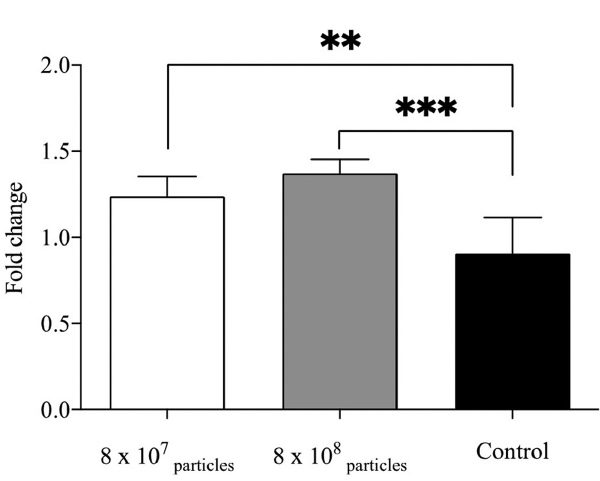
Figure 4. The transcriptional response of α -SMA to coffee EPDEN treatment in LX-2 cells. The error bars reflect the SDs of the results derived from the biological triplicate experiments. The qRT-PCR data are presented as the fold changes of the mRNA levels in the Figure 3. The effects of coffee EPDENs concentrations at treatment groups relative to the non-treated (control) group based 8 × 10 7 , 16 × 10 7 , 24 × 10 7 , 32 × 10 7 , 4 × 10 8 , 48 × 10 7 , 56 × 10 7 , on the normalization against the GAPDH. All the data are presented 64 × 10 7 , 72 × 10 7 , and 8 × 10 8 particles/µL on LX-2 cells (A–B) as mean ± SD. Significance level, * P < .05 versus control and 2 × 10 8 , 4 × 10 8 , 6 × 10 8 , and 8 × 10 8 particles/µL on Hep 40 cells after 24- and 72-hour treatments (C–D). The data represent the mean and SD of the triplicate samples. All the data are represented as the mean ± SD (n = 3). Significance level, * P < .05 versus control group. EPDENs, edible plant-derived exosome-like nanoparticles; SD, standard deviation.